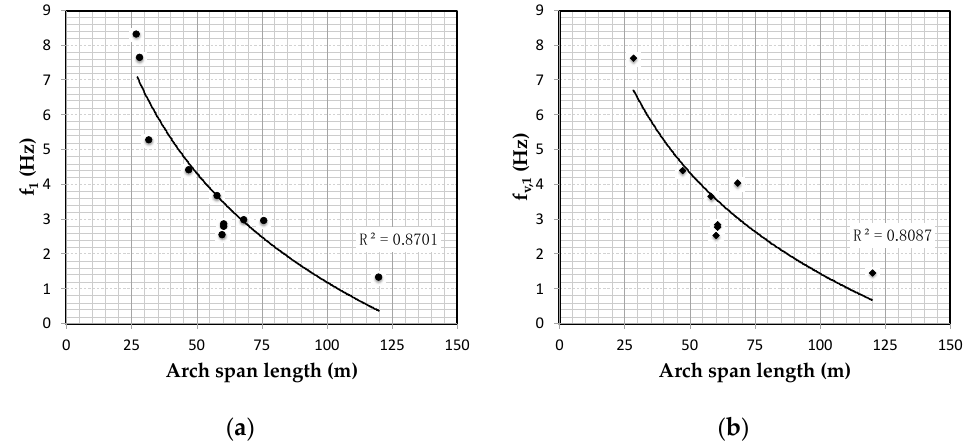
Figure 2. Empirical correlations for the prediction of the fundamental frequency of RC arch bridges ( a ), the fundamental frequency of RC arch bridges corresponding to an antisymmetric vertical bending mode ( b ).